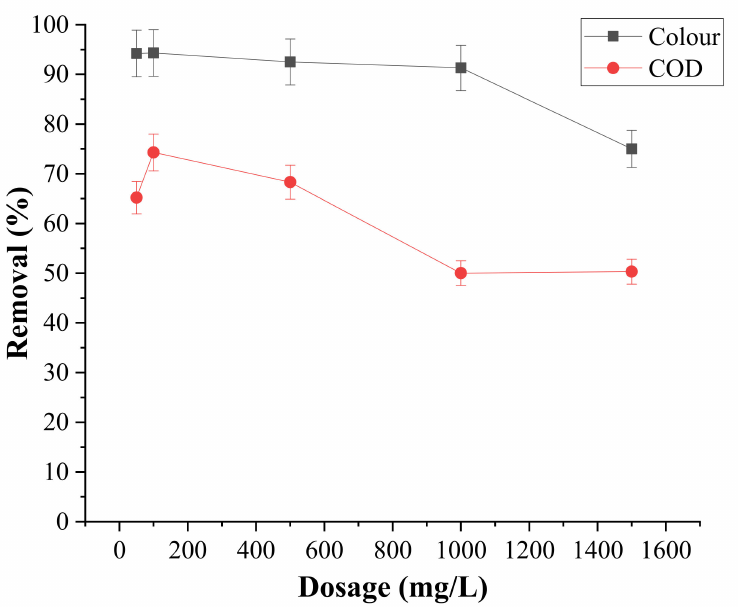
Figure 6. Removal of colour and COD pH 8 and 6000 mg/L SnCl 4 with the presence of PAM as the coagulant